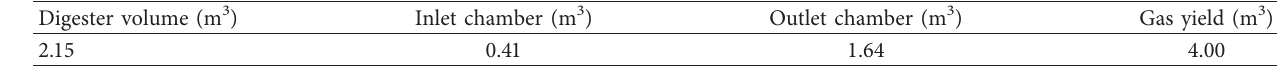
Figure 6: Experimental setup for the ventilation Table 3: Determination of biogas digester components and gas yield.